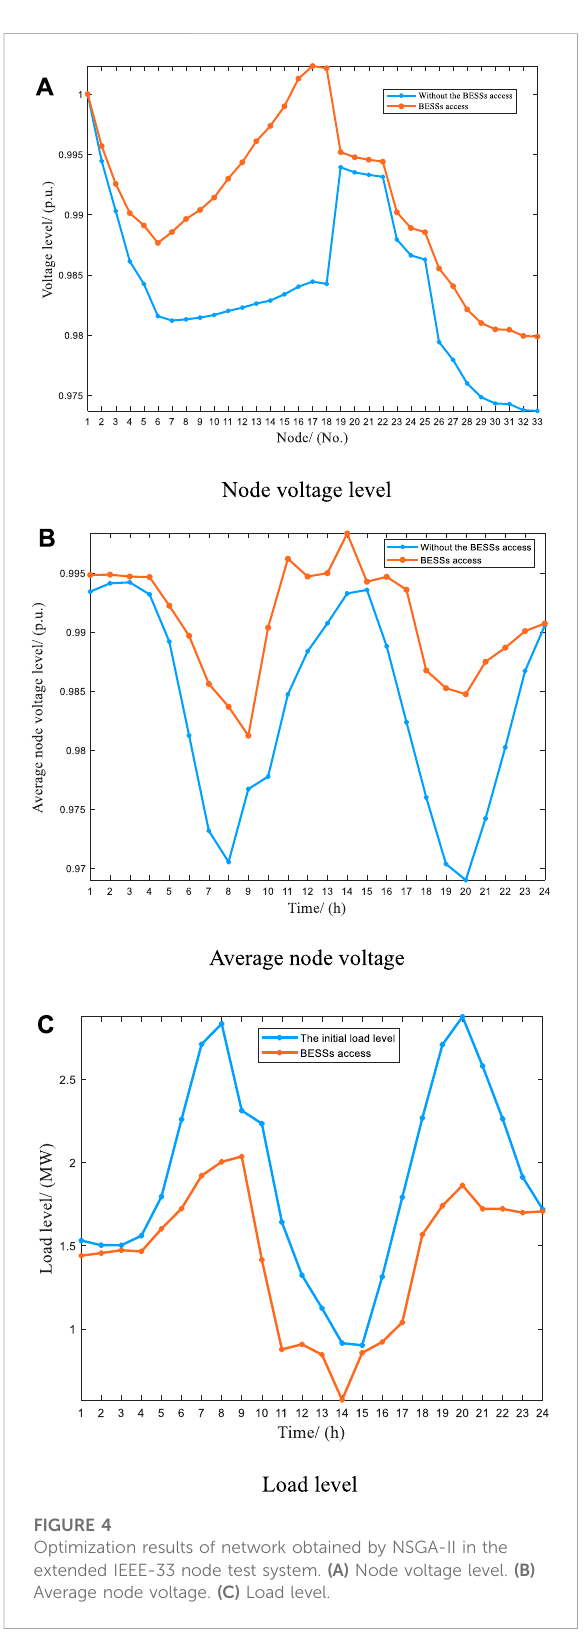
FIGURE 4 Optimization results of network obtained by NSGA-II in the extended IEEE-33 node test system. (A) Node voltage level. (B) Average node voltage. (C) Load level.